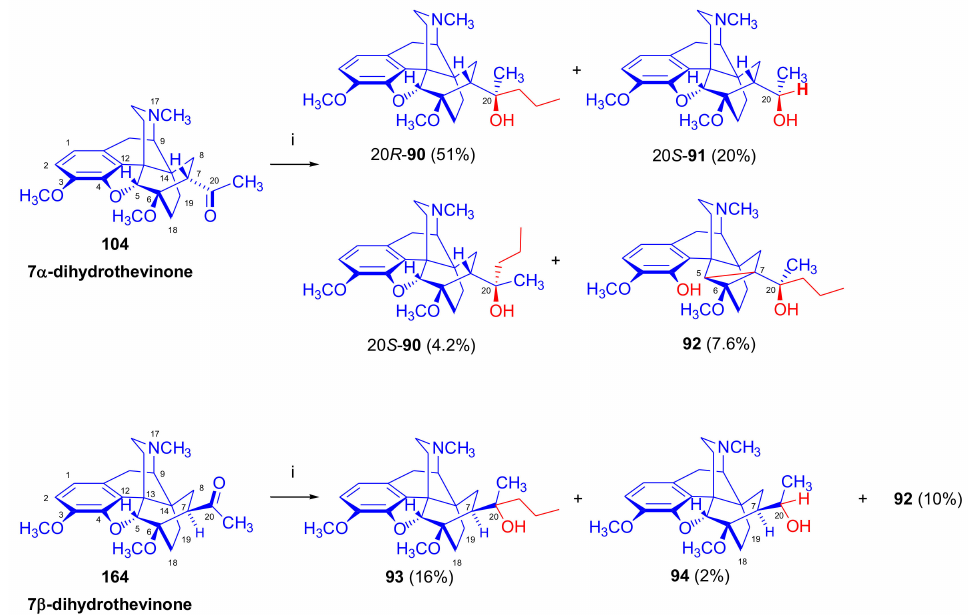
Figure 31. Grignard reaction of 7 α -dihydrothevinone with n -propylmagnesium bromide. Reagents and conditions : (i): 6 equiv. n -propylmagnesium bromide, toluene-THF or toluene-diethylether, 2